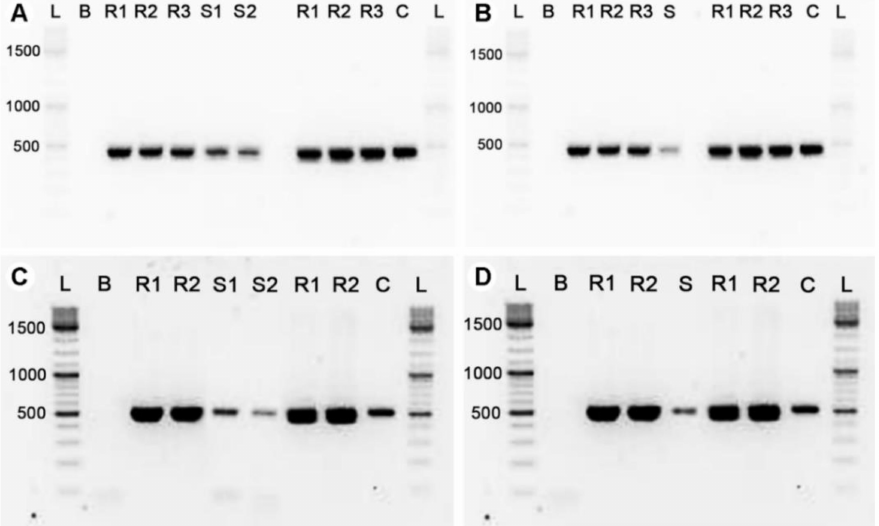
Figure 2. Visualization of the PCR products for microcystin synthetase ( mcyE ) from KBWPS ( A ) and Lake Balaton ( B ), as well as for saxitoxin synthetase ( sxtG ) from KBWPS ( C ) and Lake Balaton ( D ). L: ladder; B: blank; S: sample from June 2018 (Lake Balaton); S1: sample from July 2018 (KBWPS); S2: sample from September 2018 (KBWPS); R1-R3: reference strains; C: exogenous amplification control. Table 5. Presence and concentration of nine MC congeners of the Kis-Balaton Water Protection System (KBWPS) and Lake Balaton during the investigated period of 2018. KBWPS Balaton MC Variant ( µ g/L) July September